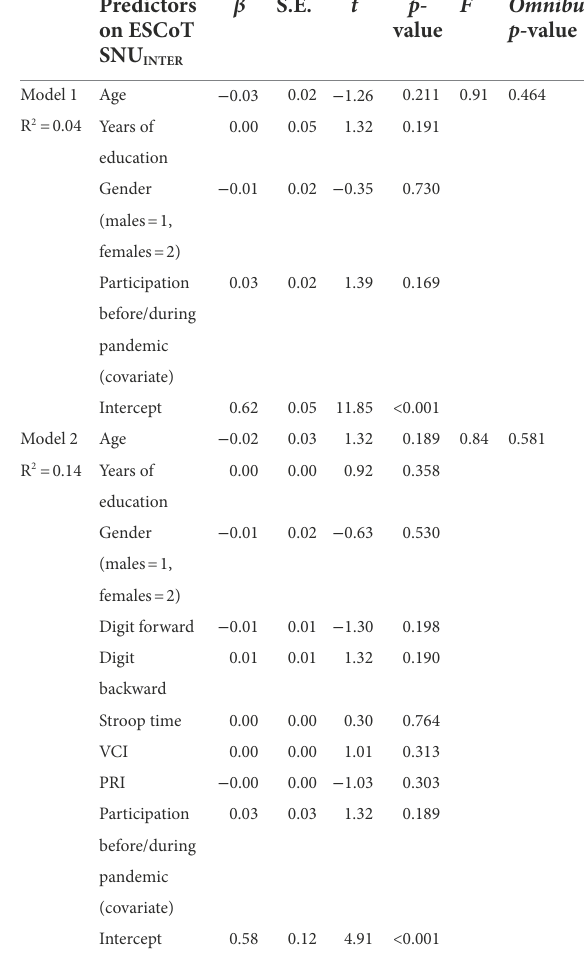
TABLE 6 Multiple regression results for predictors of ESCoT SNU INTER total